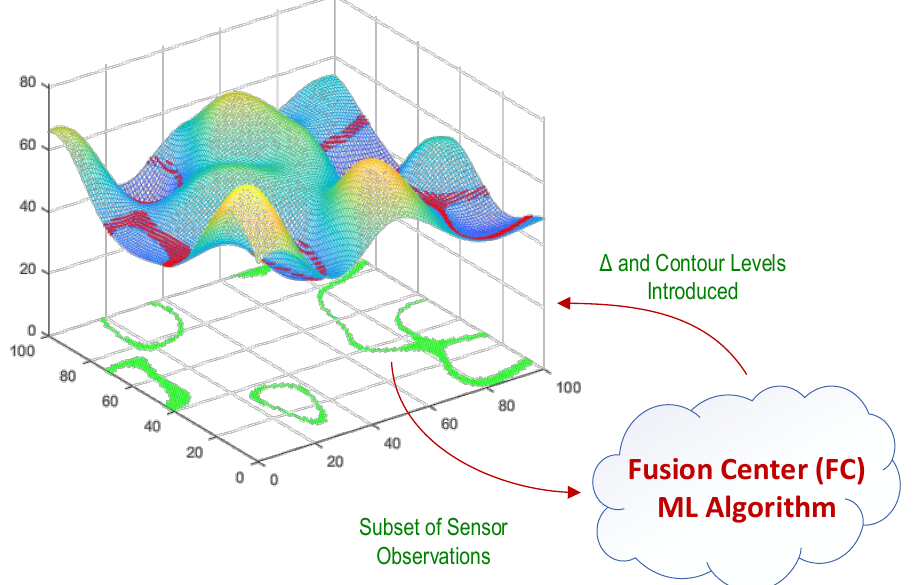
Figure 1. A subset of sensor observations are reported in response to the FC’s query to reconstruct the signal. The FC uses these sensor observations for feature extraction and reconstruction of the spatial signal. This figure illustrates a given subset of wireless sensors with green color and their related sensor observations in margin of a given contour level, with red colors on spatial signal